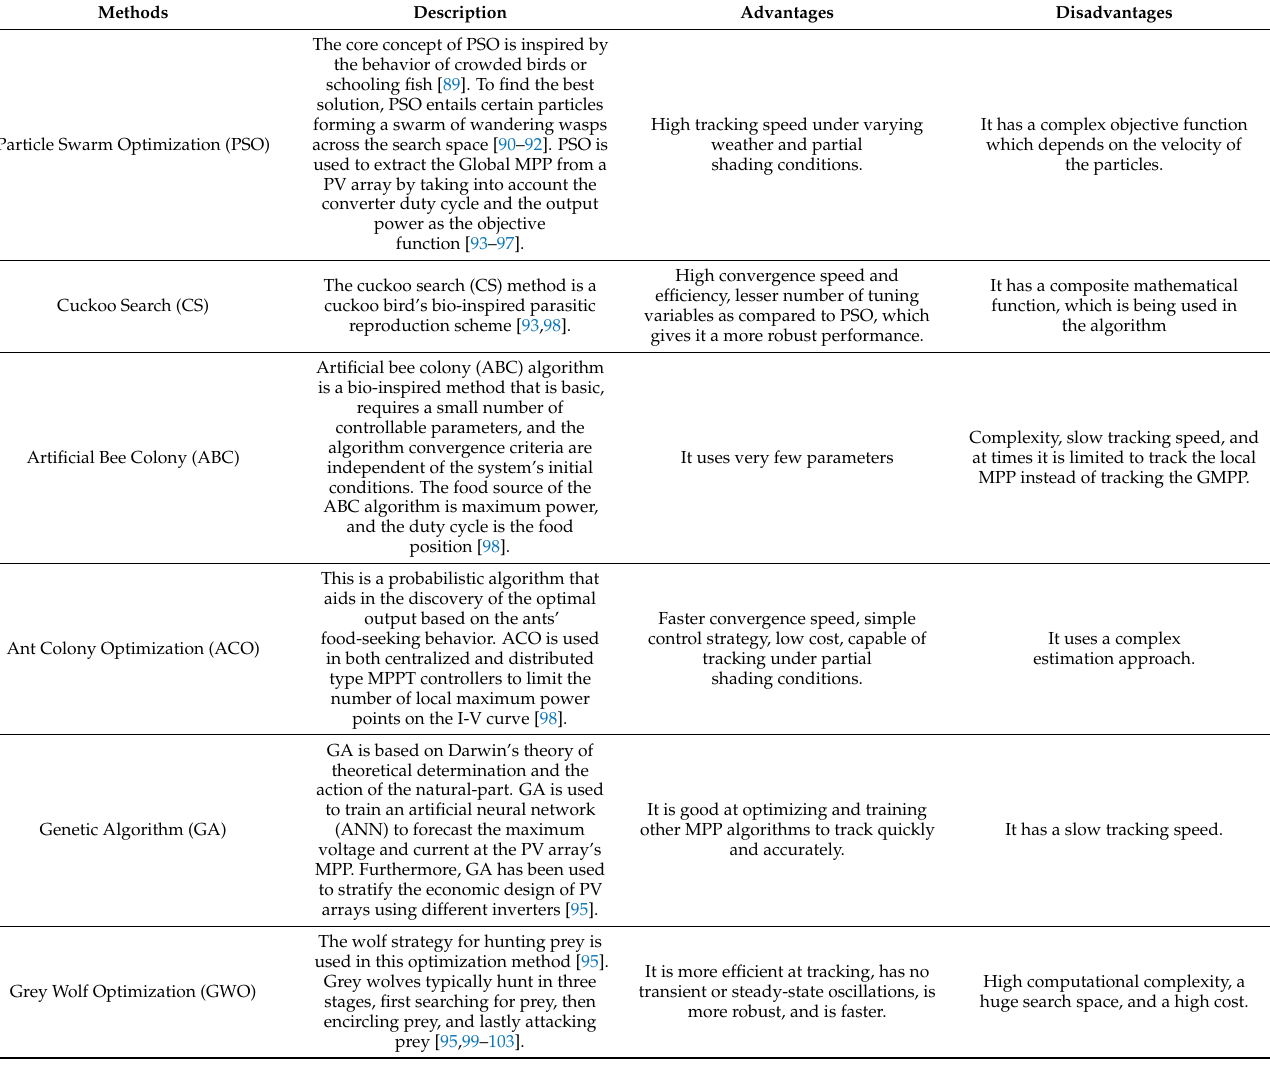
Table 5. Metaheuristic optimization